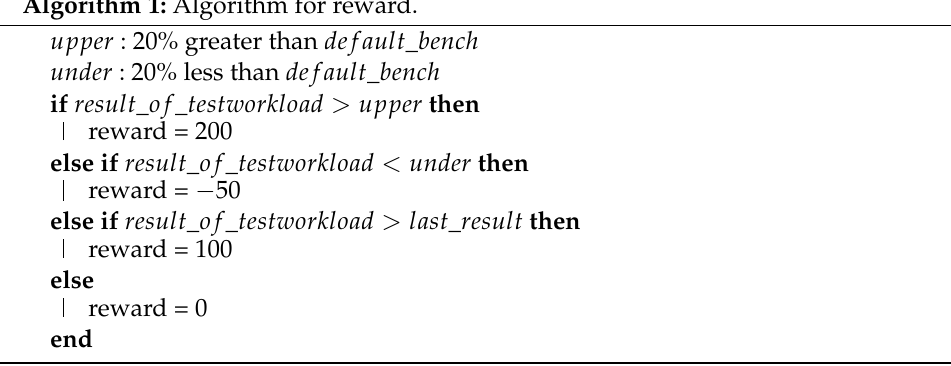
Algorithm 1: Algorithm for reward.